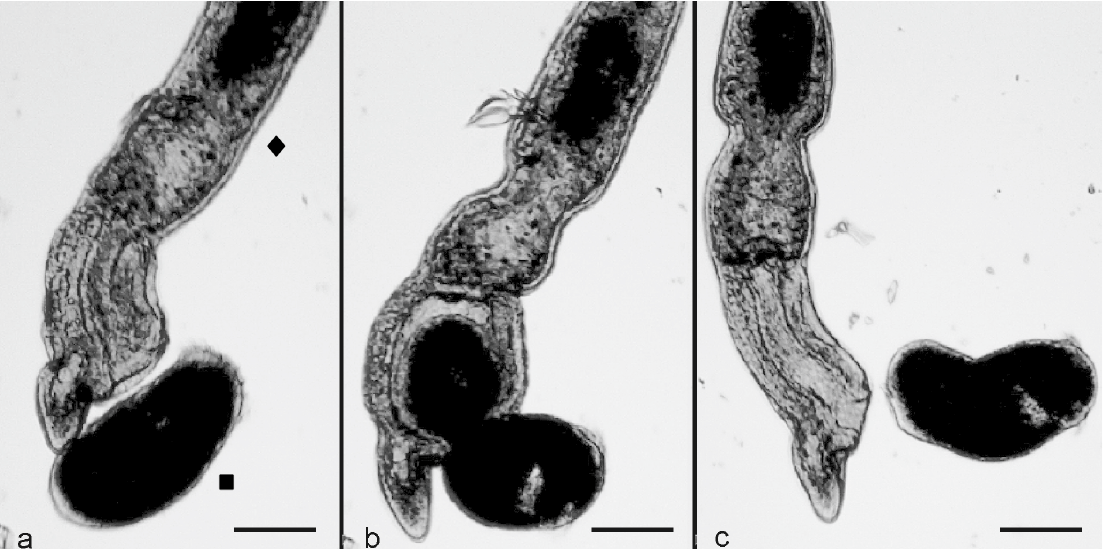
Figure 4. The predator-prey interaction between the microturbellarian S. sphagnetorum ( (cid:117) ) and S. polymorphus ( (cid:4) ). ( a ) A specimen of S. sphagnetorum contacts a cell of S. polymorphus with its oral apparatus while the prey shows a quick contraction. ( b ) The predator partially engulfs its prey. ( c ) the contracted S. polymorphus cell is disgorged alive within one second. Photomicrographs obtained from a film clip. Scale bar = 100 µ m.